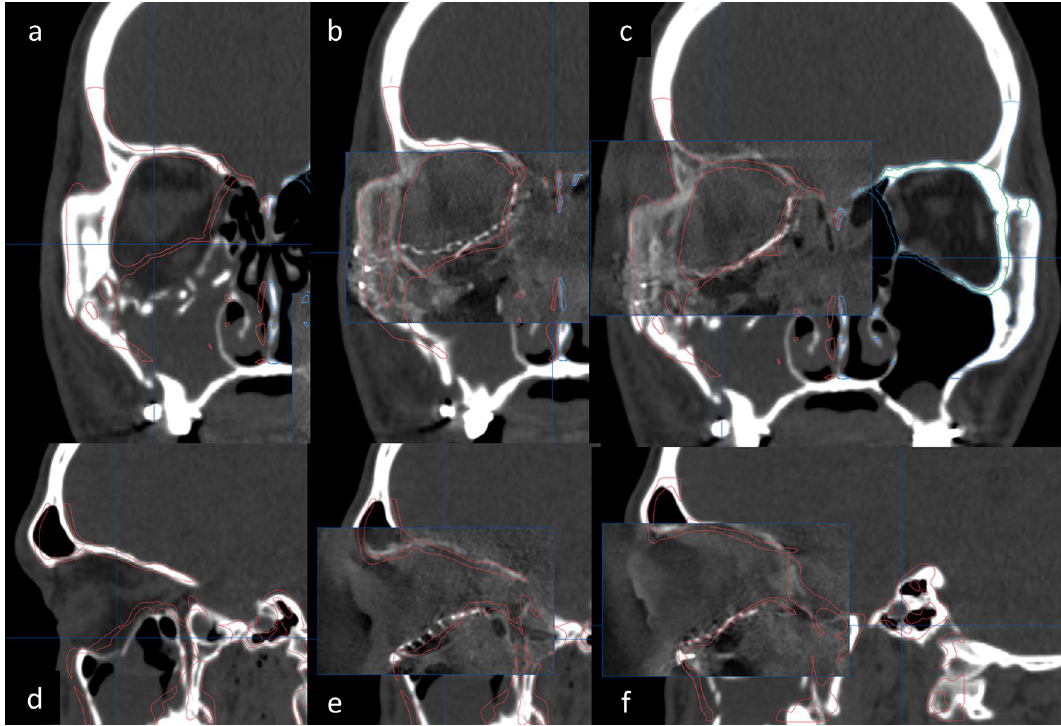
Figure 6. The implant adjustment of orbital reconstruction after intraoperative 3D C-arm computed tomography use. The right orbital floor fracture was shown on the coronal and sagittal view ( a , d ). After reconstruction, the 3D C-arm CT was applied, and the result revealed that the implant position was not in conformity with the presurgical plan ( b , e ). The adjustment was made for better reconstruction ( c , f ).